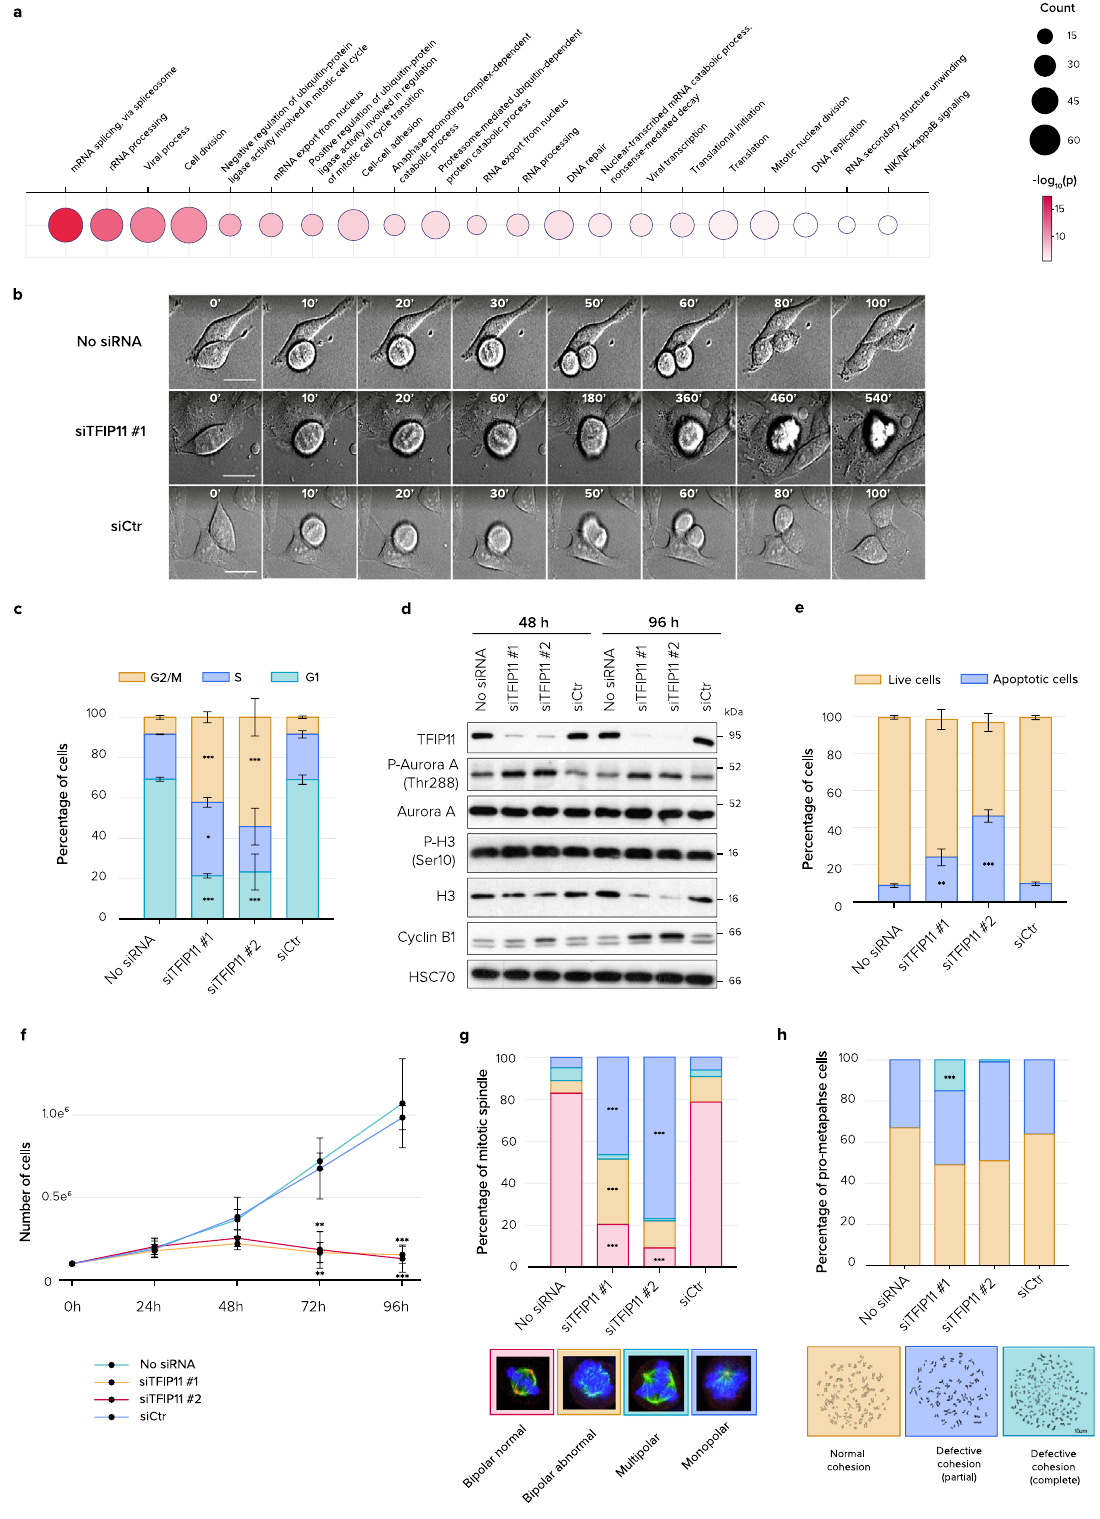
supernatants was extracted using the trizol/chloroform method and eluted in 20µl of RNase-free water. For quantitative analysis of RNAs bound by FBL, the per- centage of input was calculated for each condition as: 2 ((Ct input – log2(10)) – Ct IP) x100 (10 is the dilution factor of input used for quantitative analysis). RNA-seq . For mRNA-seq from HeLa cells, libraries were prepared with the Illu- mina TruSeq stranded mRNA protocol and 2× 76-bp sequencing was performed